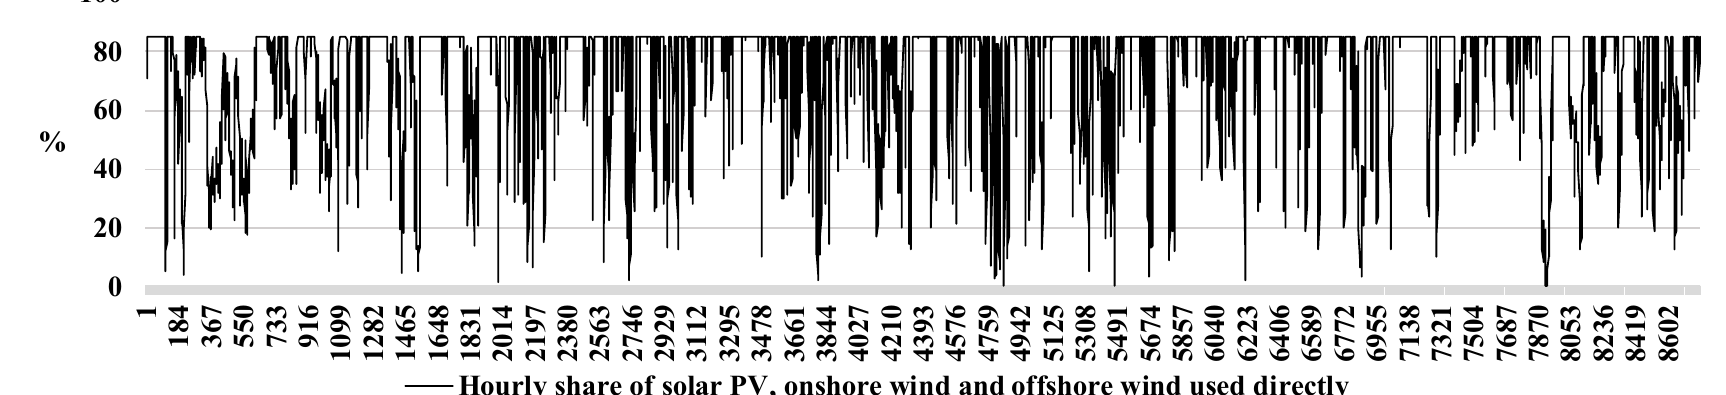
Figure 7. Amount of solar PV, onshore wind and offshore wind that is directly consumed (%). Values are in the range of 0–85% with a mean of 73%. As a result of high direct utilization of RE and extensive use of V2G storage, there was noticeably less need for gas and thermal storage.